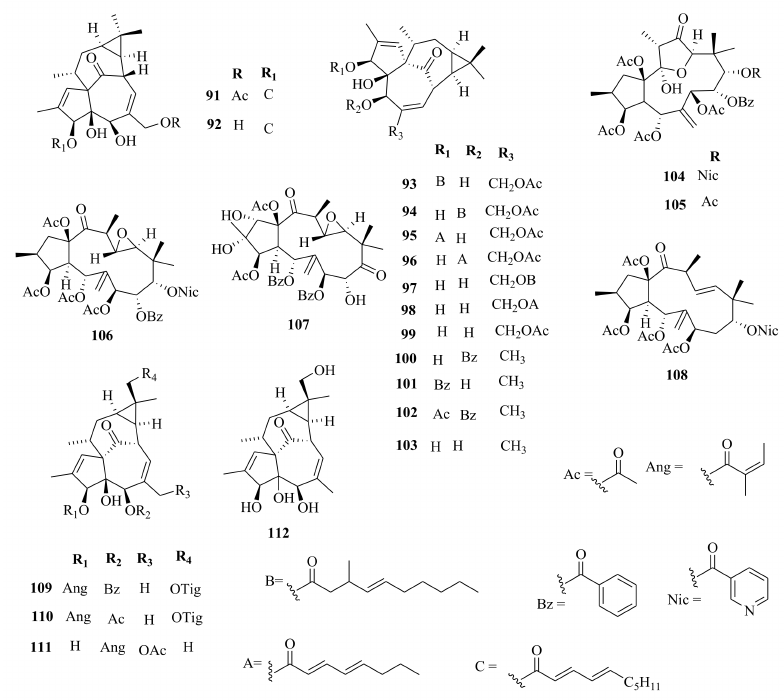
Figure 5. Structures of Euphorbia ingenane diterpenoids.